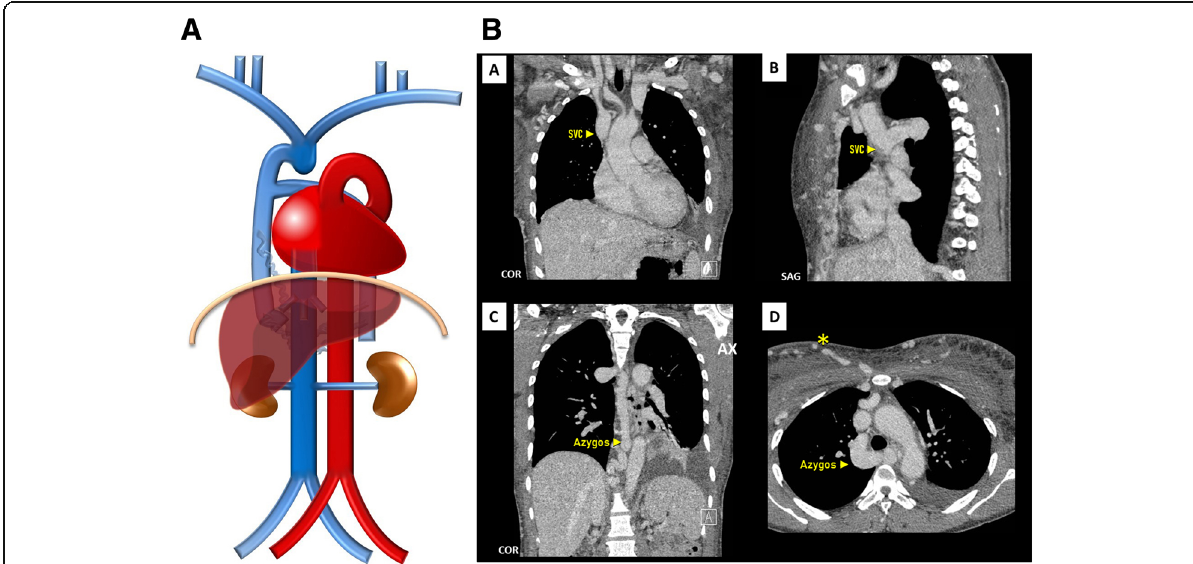
Fig. 4 a Interrupted SVC schematic. In an absence of the SVC, the venous blood from the upper body drains into the persistent azygo-hemiazygos system of veins subdiaphragmatically, with prominent collateral vessels that allow a sufficient venous return by cavo-caval anastomoses. b Interrupted SVC imaging contrast-enhanced CT showing an interruption of the SVC [A, B] with exuberant collateral circulation by the azygos-hemiazygos venous system [C, D] and collaterals of the anterior chest wall (asterisk)